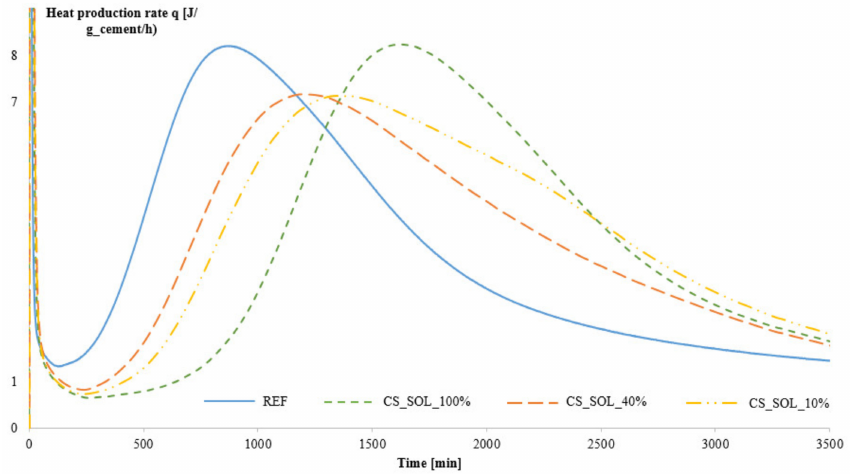
Figure 6. Hydration kinetics of the reference mixture and the mixtures containing SAPs, di ff erent amount of solubles (Series